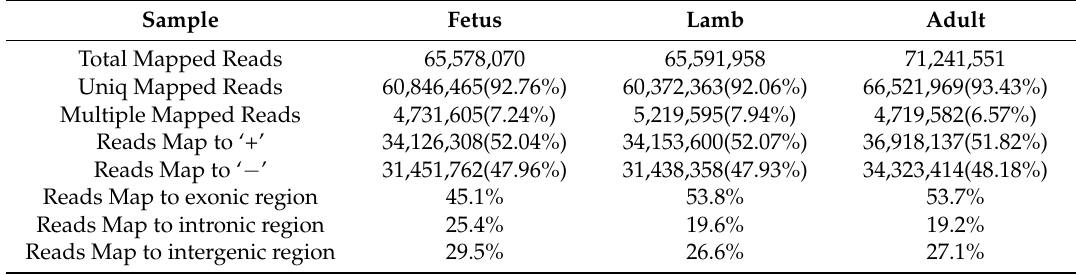
Table 1. Summary of clean reads mapping to the Ovis aries reference genome in different